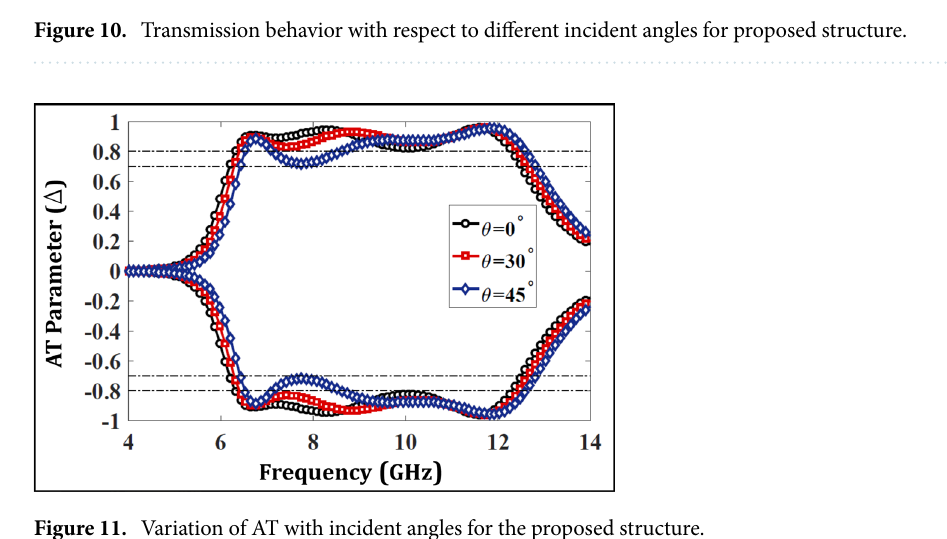
Figure 11. Variation of AT with incident angles for the proposed